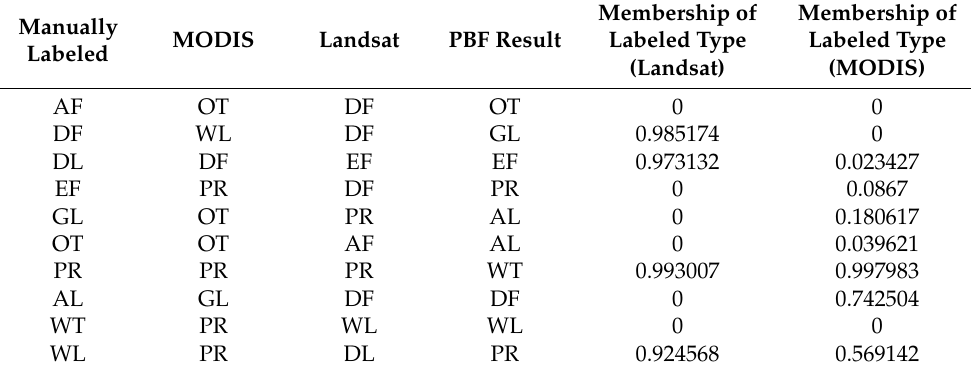
Table 6. Analysis of the misclassification of classification